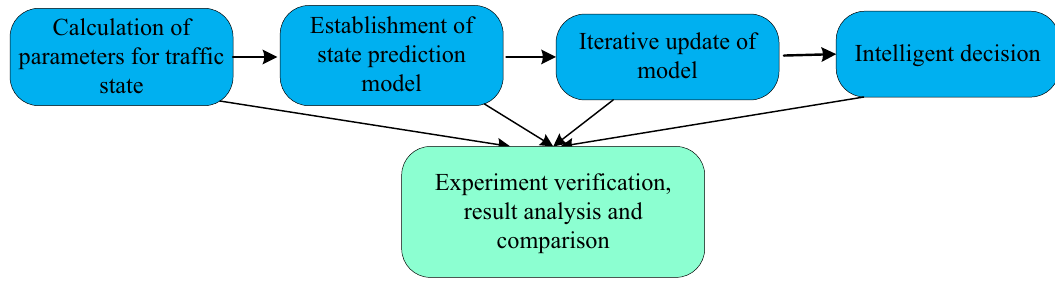
Figure 1. Flow chart of traffic flow prediction and decision